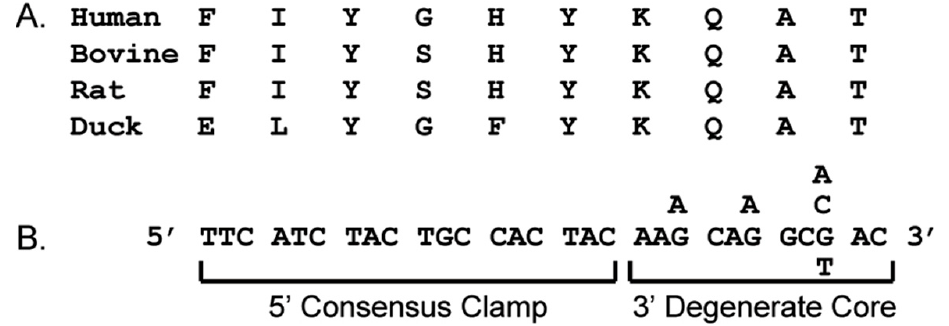
Figure 1. Anatomy of a “consensus-degenerate hybrid oligonucleotide primers” (CODEHOP) PCR primer. A CODEHOP is a pool of related primers containing all possible nucleotide sequences encoding 3 to 4 highly conserved amino acids within a 3 ′ degenerate core and a 5 ′ consensus clamp containing the most probable nucleotide at each position for the flanking codons. ( A ) multiple alignment of protein sequences; ( B ) predicted CODEHOP primer pool.